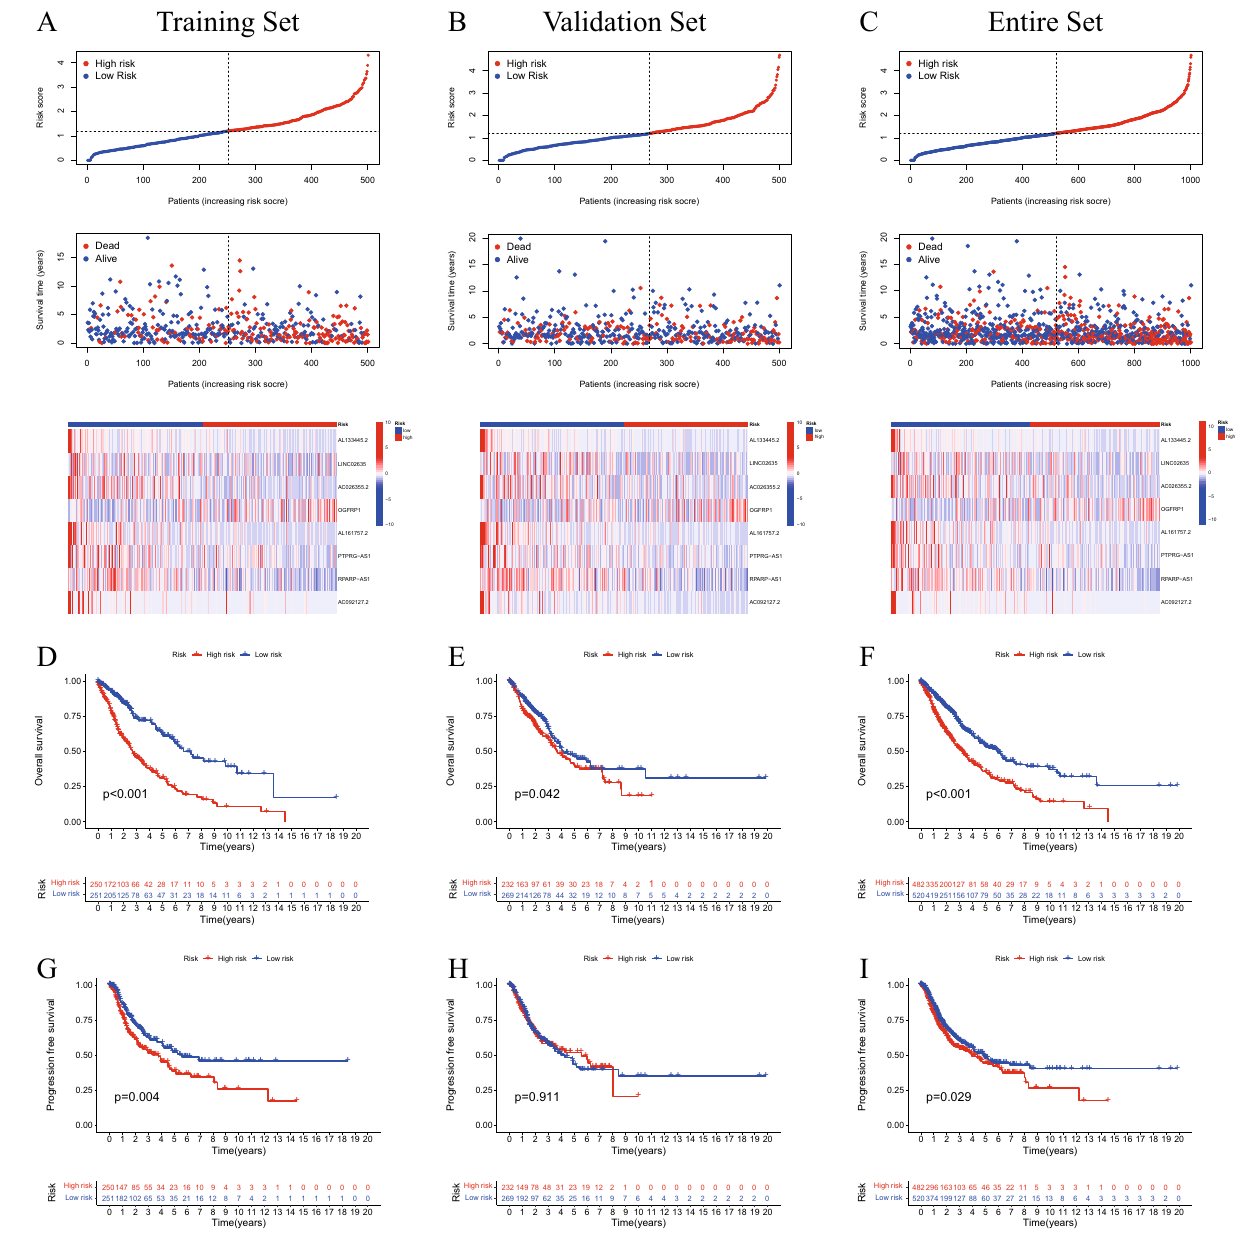
Figure 3. Prognosis of patients with lung cancer is accurately predicted by a cuproptosis-related lncRNA signature. The 8 cuproptosis-related lncRNAs were expressed in low- and high-risk groups in the training set ( A ), validation set ( B ) and entire set ( C ), with respect to risk score distribution, survival status and expression. K-M survival curve analyses of OS of patients with lung cancer in the training set ( D ), validation set ( E ) and entire set ( F ). K-M survival curve analyses of PFS of patients with lung cancer in the training set ( G ), validation set ( H ) and entire set ( I ). K-M, Kaplan–Meier; lncRNA, long non-coding RNA; OS, overall survival; PFS, progression-free